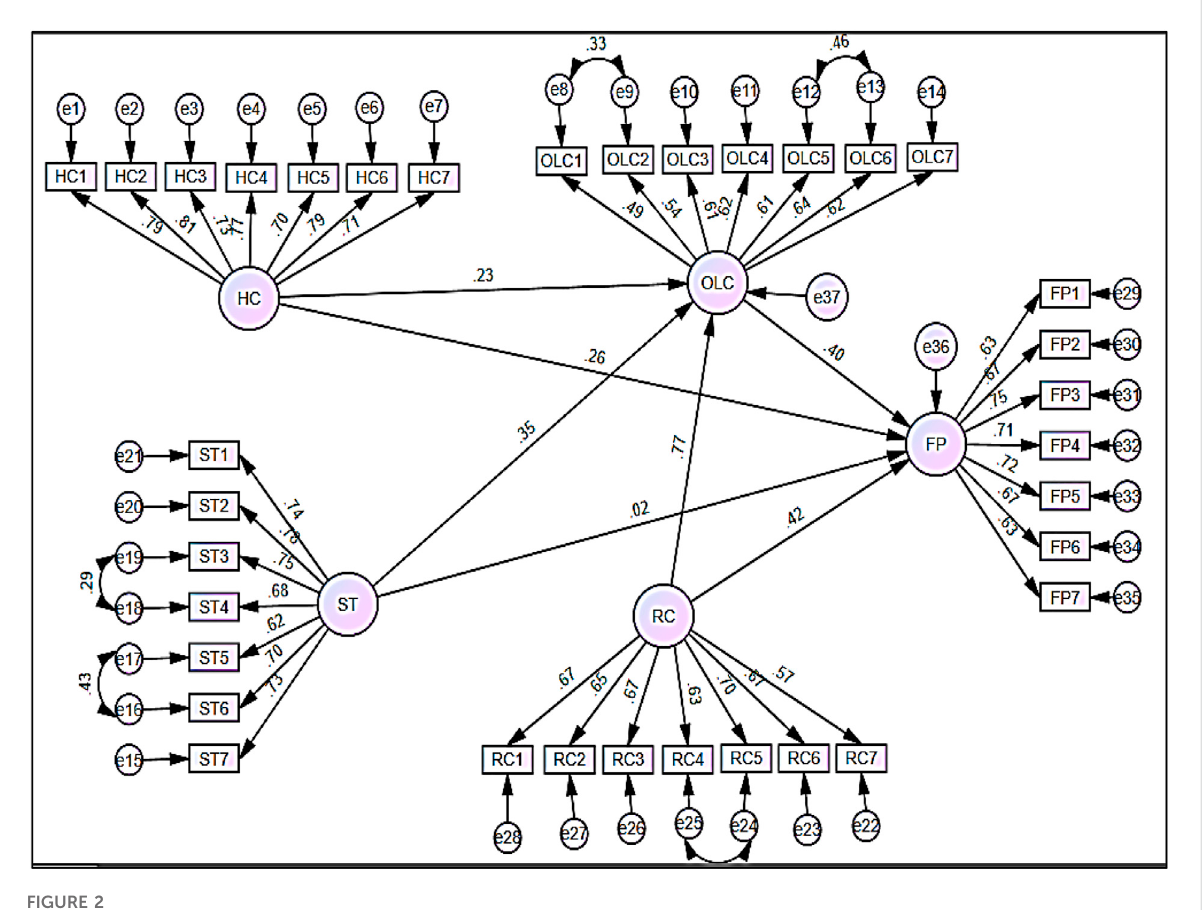
FIGURE 2 Results for hypothesis evaluation.